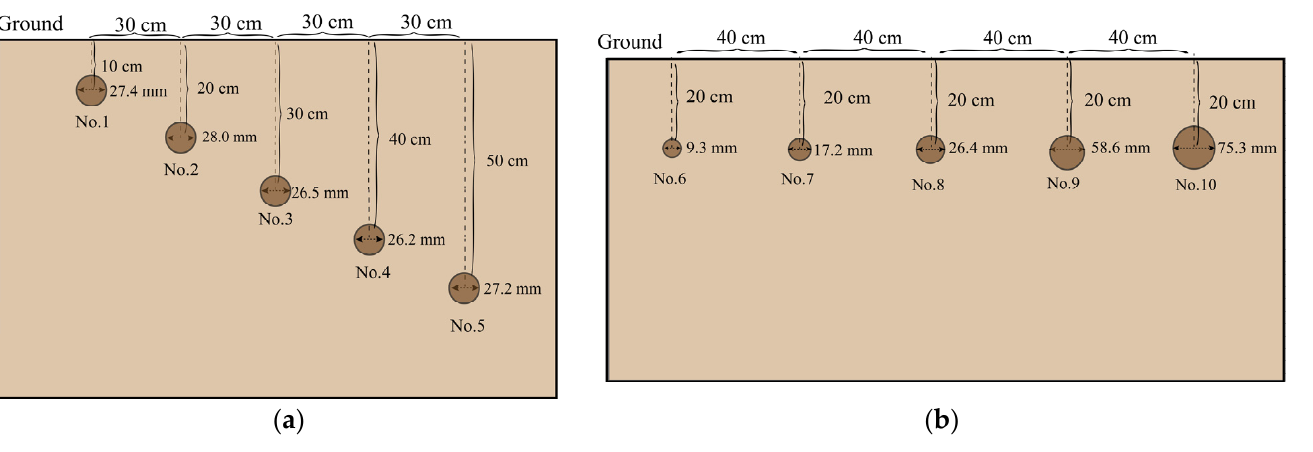
Figure 7. Schematic diagram of pre-buried root test: ( a ) different depth; ( b ) different root diameters.